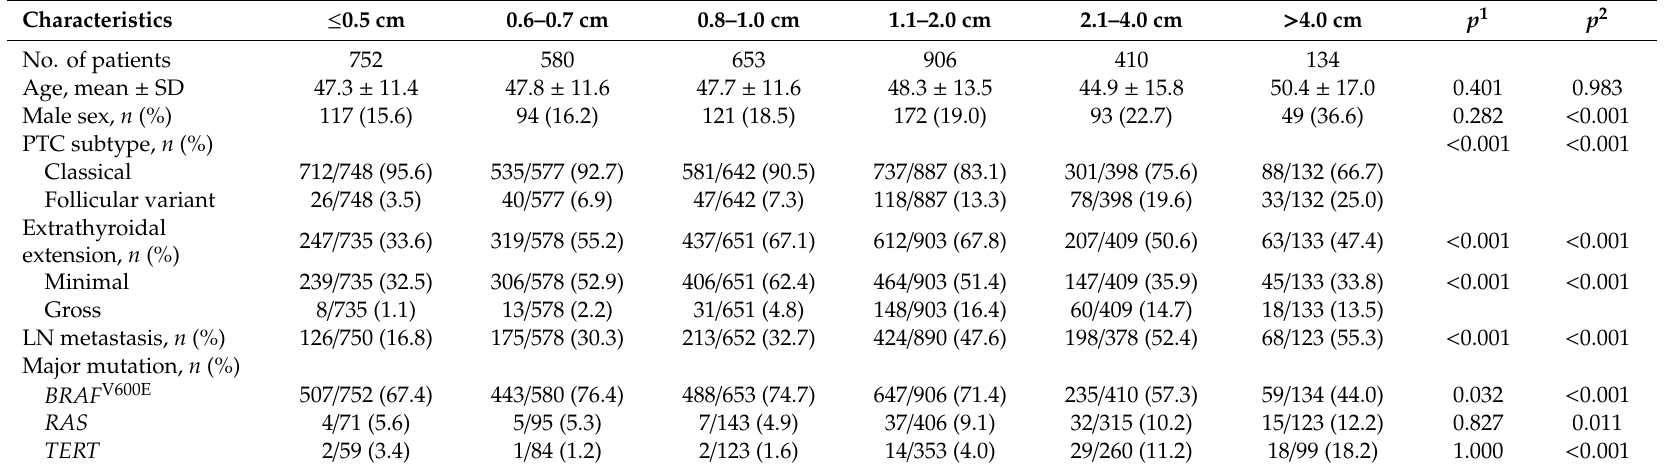
Table 2. Clinicopathological and genomic characteristics of papillary thyroid carcinoma (PTC) according to tumor